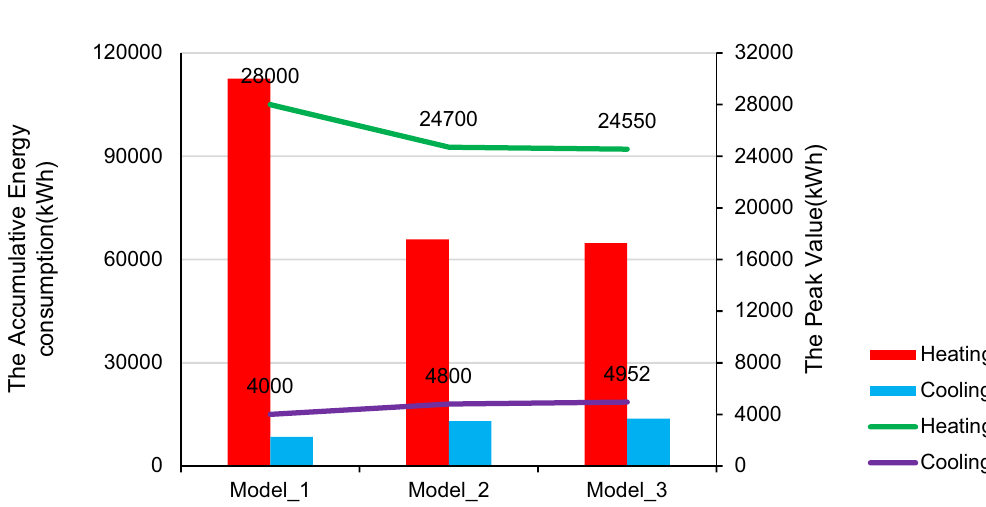
Figure 10. The variations in the heating and cooling consumption from the accumulative amount and peak